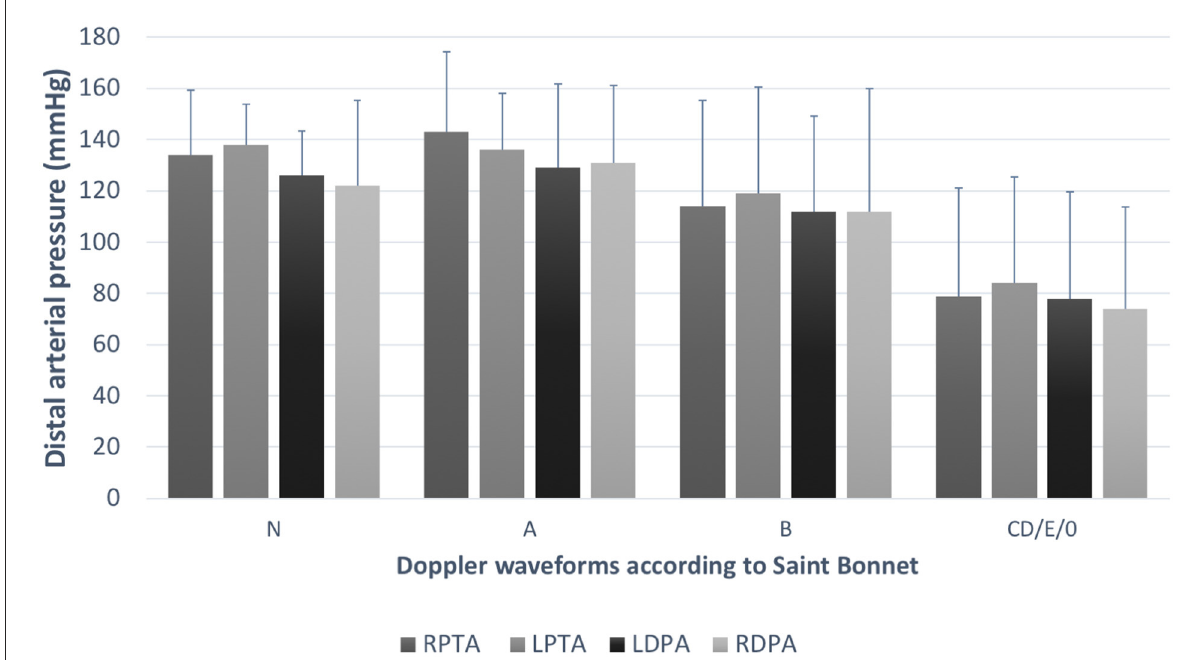
FIGURE2 Distal pressures according to Doppler waveforms. This graph shows the mean arterial pressure (and the standard deviation) according to the Doppler waveform in each lower extremity artery from both legs. We can observe a trend of decreasing pressure with flow alteration. TPA, tibial posterior artery (RTPA,right TPA; LTPA, left TPA); DPA, dorsalis pedis artery (RDPA, right DPA; LDPA, left DPA).